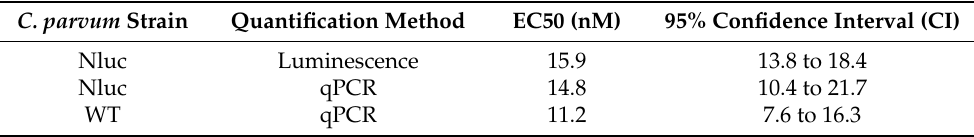
Table 1. EC 50 of trtE against Nluc and WT C. parvum when measured by luminescence or qPCR. C. parvum